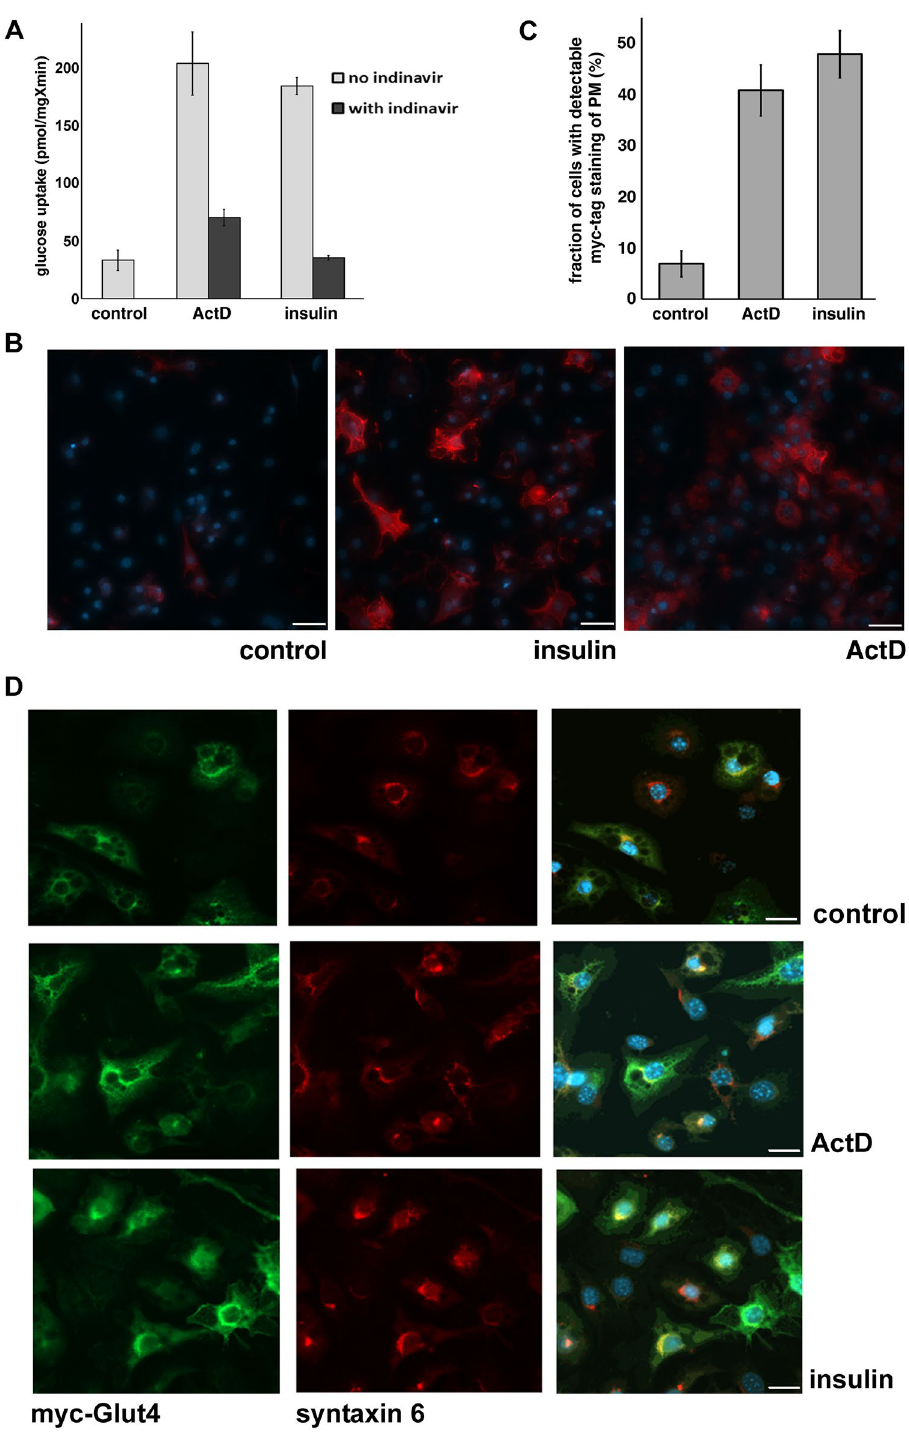
Figure 2. Actinomycin D-dependent upregulation of glucose uptake in adipocytes is mediated by Glut4. Panel ( A ): Differentiated 3T3-L1 adipocytes were treated or not treated with ActD (5 µM) for 18 h or insulin (100 nM) for 15 min and assayed for glucose uptake. Indinavir (50 µM) was added to the indicated samples 4 h before the glucose uptake assay and preserved throughout the assay. The error bars represent standard deviations. Panel ( B ): Differentiated 3T3-L1 adipocytes stably expressing myc 7 -Glut4 were treated or not treated with ActD (5 µM) for 18 h or insulin (100 nM) for 15 min, fixed and stained with anti-myc monoclonal antibody, Alexa Fluor 594-conjugated goat anti-mouse secondary antibody and DAPI without permeabilization. Representative images were obtained at the same exposure. The space bar corresponds to 50 µM. Panel ( C ): Quantification of results shown in panel B. The error bars represent standard deviations. Panel ( D ): Adipocytes stably expressing myc 7 -Glut4 were treated or not treated with ActD (5 µM) for 18 h or insulin (100 nM) for 15 min, fixed, and permeabilized. myc 7 -Glut4 was visualized with rabbit anti-myc antibody and Alexa Fluor 488-conjugated goat anti-rabbit antibody. Syntaxin 6 was stained with monoclonal anti-syntaxin 6 antibody and Alexa Fluor 594-conjugated goat anti-mouse antibody . Representative images were obtained at the same exposure. The space bar corresponds to 20